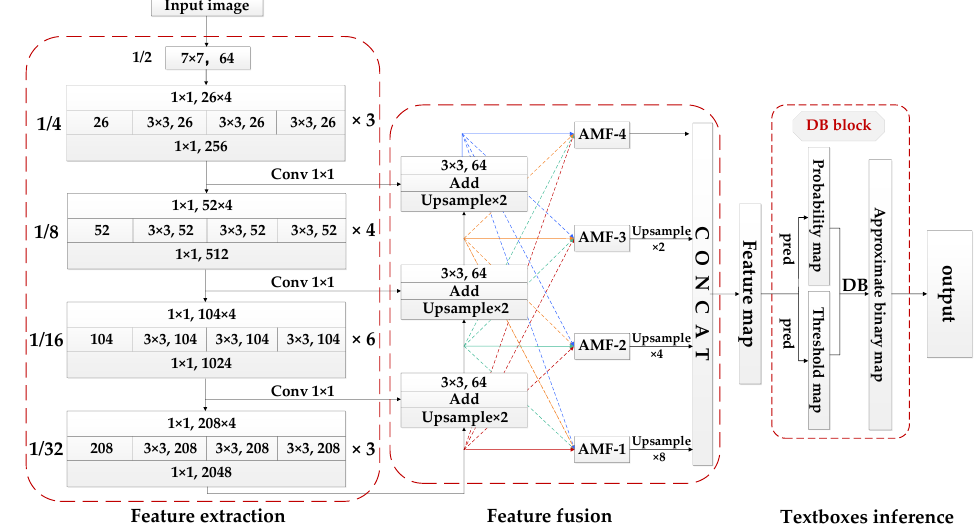
Figure 2. The framework of the proposed text detection model. It includes a Res2Net backbone network for feature extraction; an AMF feature fusion module and a text box reasoning module based on DB method.